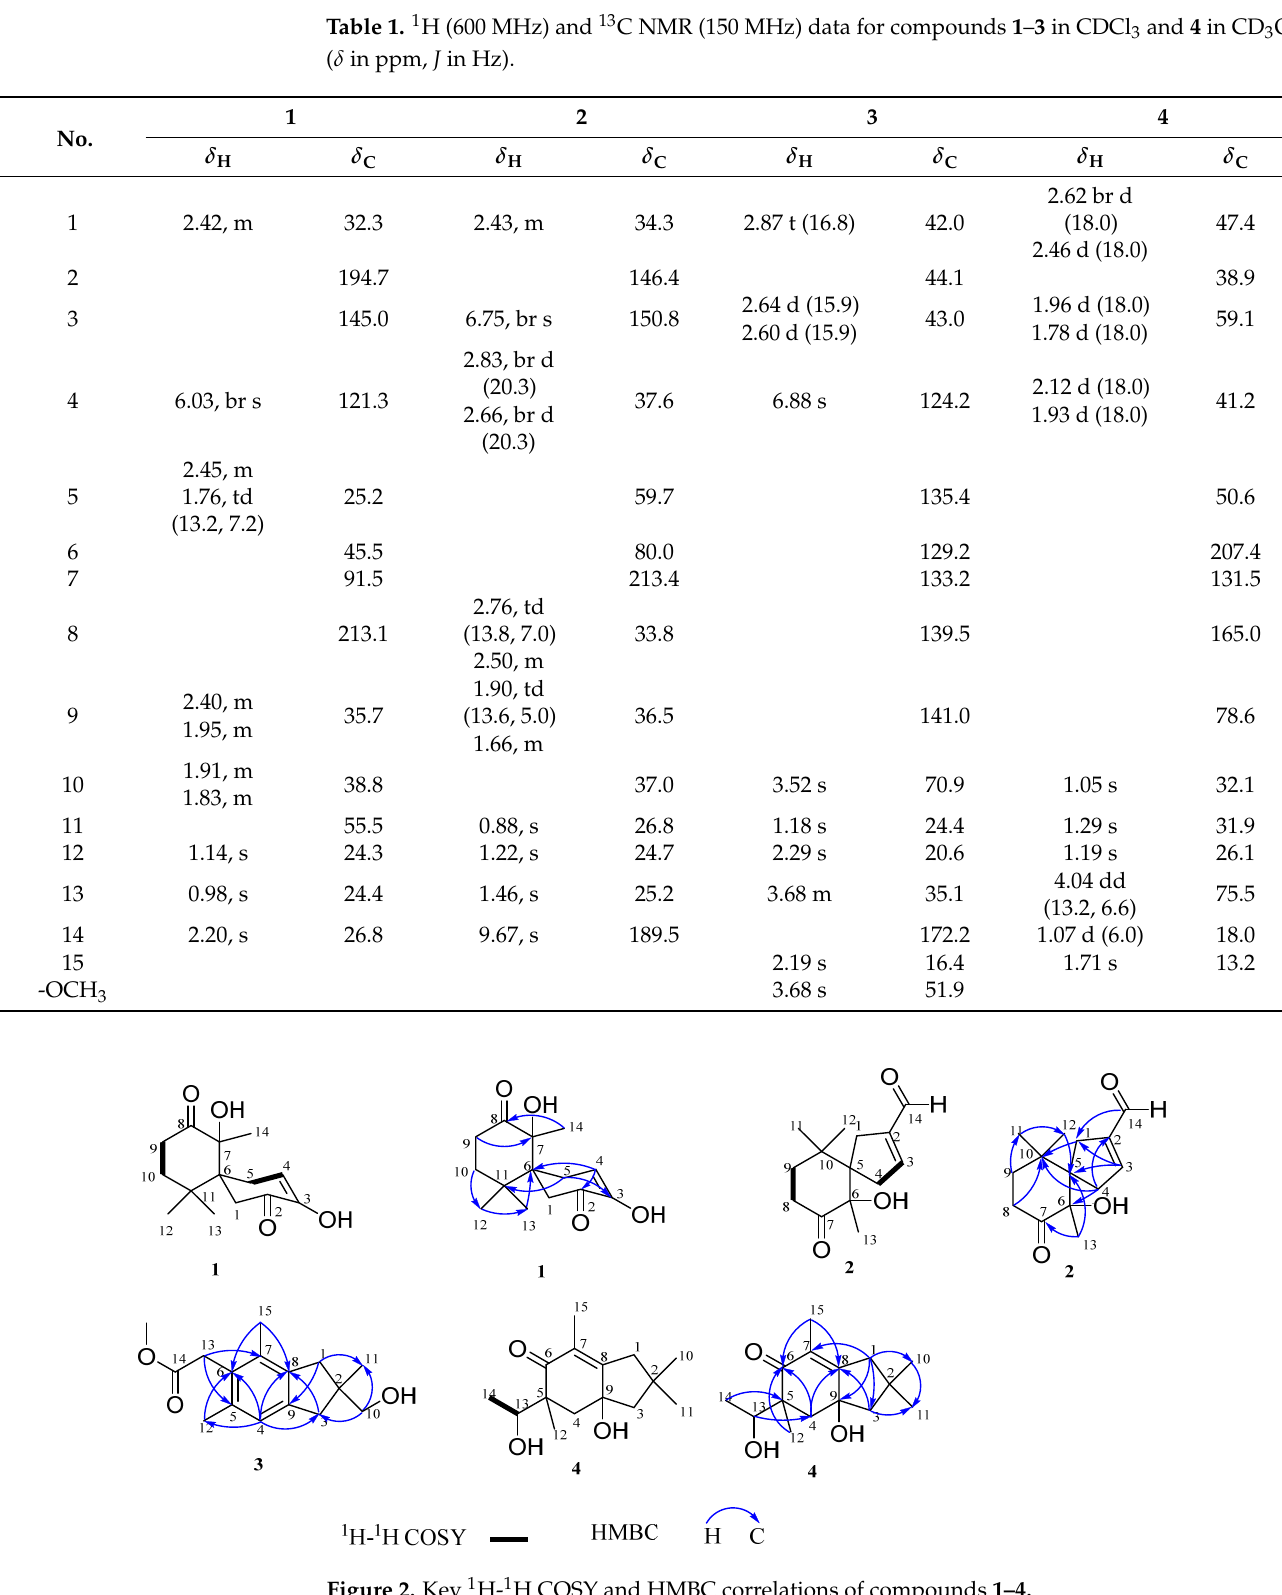
Figure 2. Key 1 H ‐ 1 H COSY and HMBC correlations of compounds 1–4. Figure 2. Key 1 H- 1 H COSY and HMBC correlations of compounds